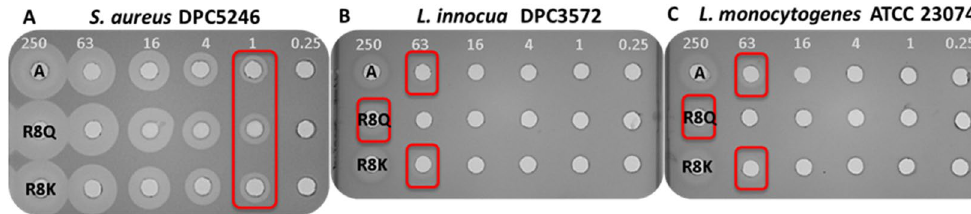
Figure 6. Activity ( µ M) of bactofencin A ( A ) bactofencin R8Q (plantaricin ST 1) and bactofencin R8K against S . aureus DPC5246 ( A ) L . innocua DPC3572 ( B ) and L . monocytogenes ATCC 23074 ( C